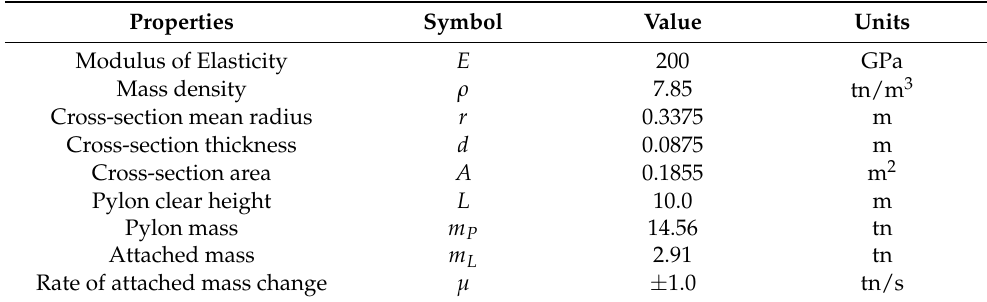
Table 1. Dimensions and properties of steel pylon used as the numerical example.